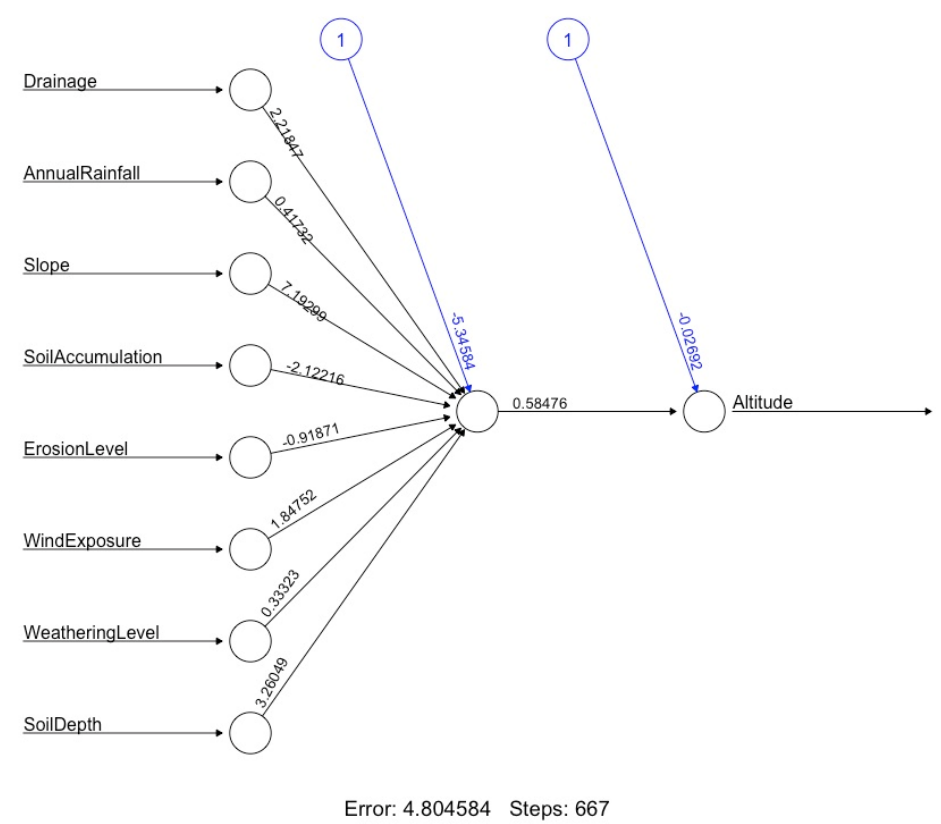
Figure 3. Multi − layer forward network with a single node to Altitude. Figure 3. Multi–layer forward network with a single node to Altitude.